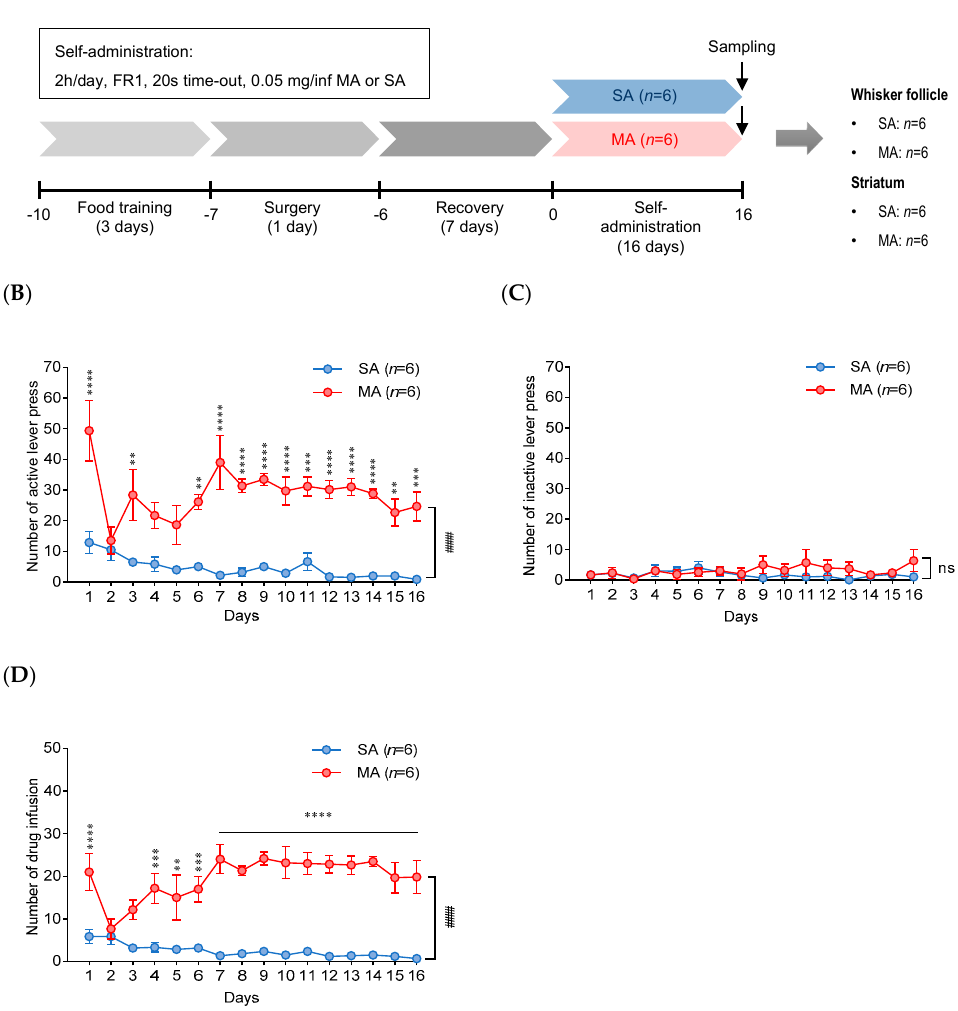
Figure 1. Methamphetamine (MA) self-administration. ( A ) The schematic diagram of the experimental timeline of saline (SA) or methamphetamine (MA) self-administration ( n = 6 per group). ( B , C ) The numbers of active and inactive lever presses by SA or MA self-administration. ( D ) The number of infusions during MA self-administration at 0.05 mg / kg (2 h / day, fixed-rate 1 (FR1), 20 s time-out). Data were displayed as mean ± SEM ( n = 6 / group) and were subjected to two-way repeated measure ANOVA, followed by Bonferroni’s multiple comparison post hoc test: ** p < 0.01, *** p < 0.001, and **** p < 0.0001 on each day; #### p < 0.0001 between groups; ns , not significant.